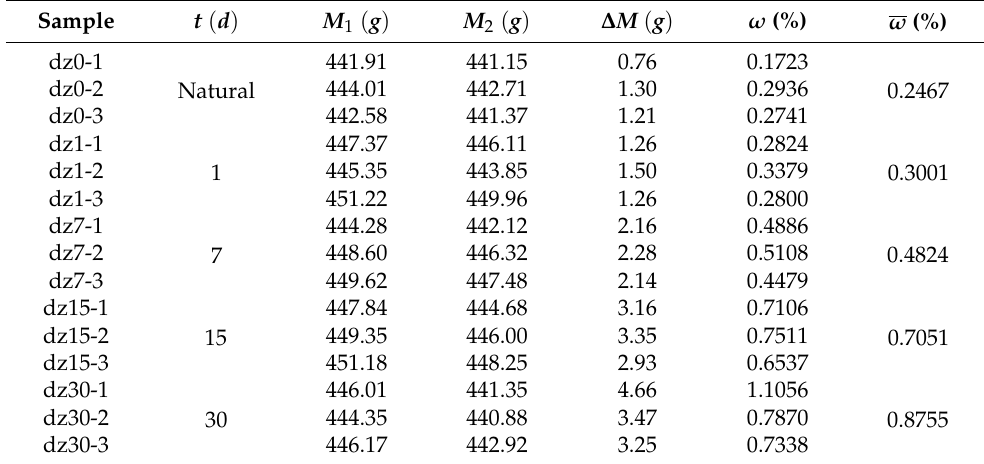
Table 1. The rock water content after immersion in water for different durations.